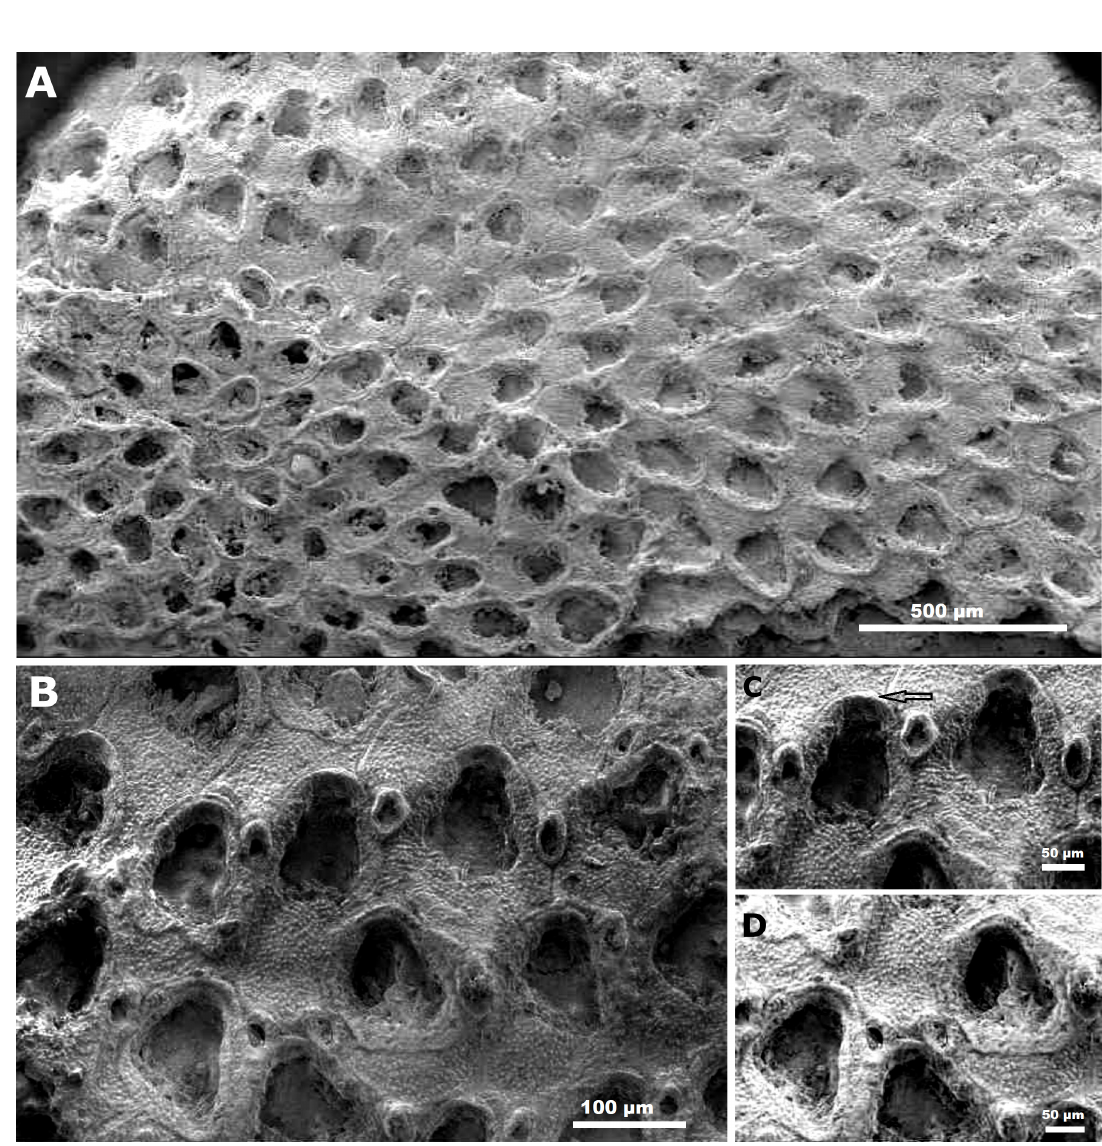
Fig. 4. Antropora ramaniaensis sp. nov., holotype (GIS/B 0440). A . General view of the colony showing rhomboidal to oval autozooids. B . Enlargement of the colony showing autozooids with extensive cryptocyst and interzooecial avicularia. C . Close-up of autozooids with cap like, endozooecial ovicells (arrow) and interzooecial avicularia. D . Close-up of autozooids with the endozooecial